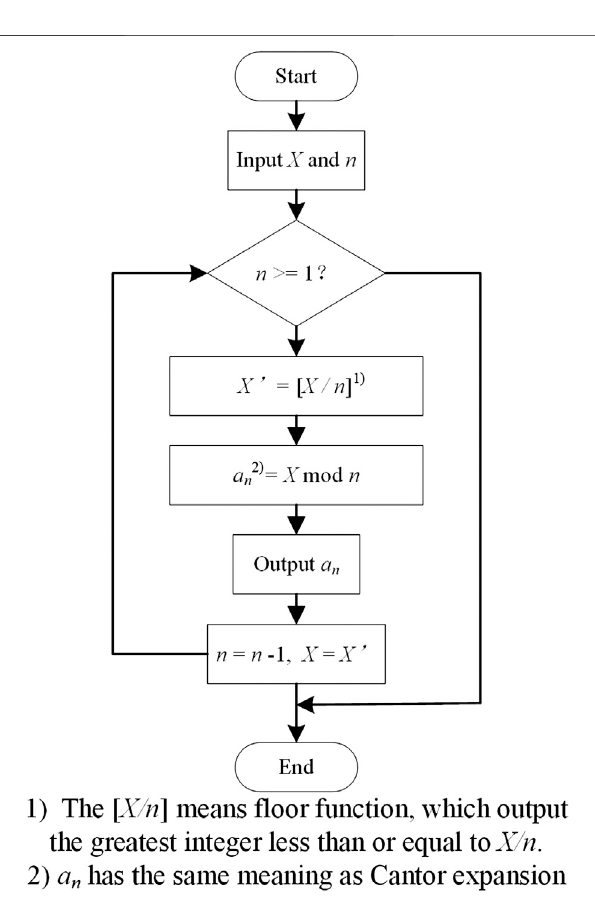
FIGURE 4 | Inverse Cantor